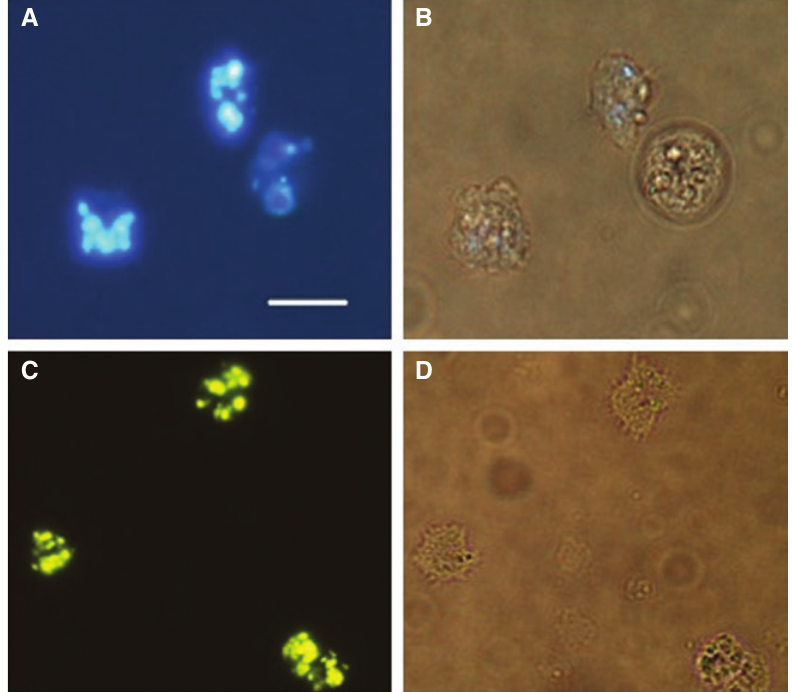
Figure 1: Auto-fluorescent vacuoles and lysosomes in growth phase cells. (A) Fluorescence microscopy images of auto-fluorescent vacuoles and (B) light field microscopy images of the same cells. (C) Fluorescence microscopy images of lysosomes stained with NBD-PZ and (D) light field microscopy images of the same cells. Scale bar = 10 μ